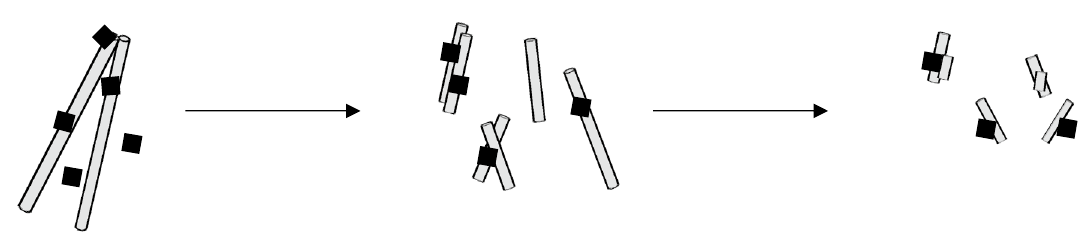
Figure 7. Schematic illustration for the degradation of insulin amyloids by